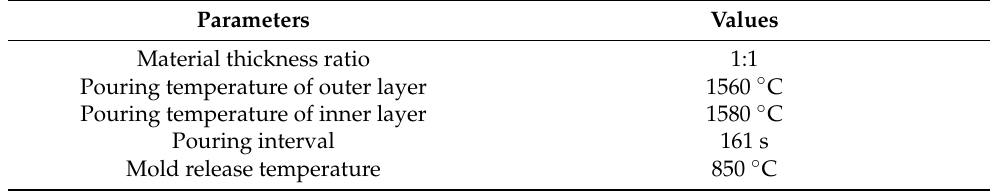
Table 1. Process parameters of centrifugal casting to prepare 40Cr/Q345B bimetallic ring blank.